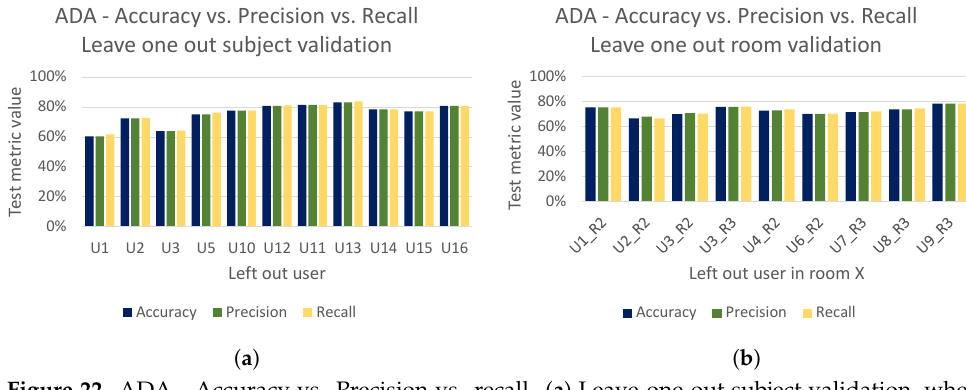
Figure 21. Leave-one-out subject/room validation. ( a ) Leave-one-out subject validation, where x-axis represents left out subject in room 1 for testing. Data set used: room locations—all, face orientations w.r.t Tx—all, gesture sample repetitions—first 3. ( b ) Leave-one-out room validation, where x-axis represents left user in room x for testing, e.g., U1_R2—user 1 in room 2. Data set used: room locations—all, face orientations w.r.t Tx—all, gesture sample repetitions—first 3.